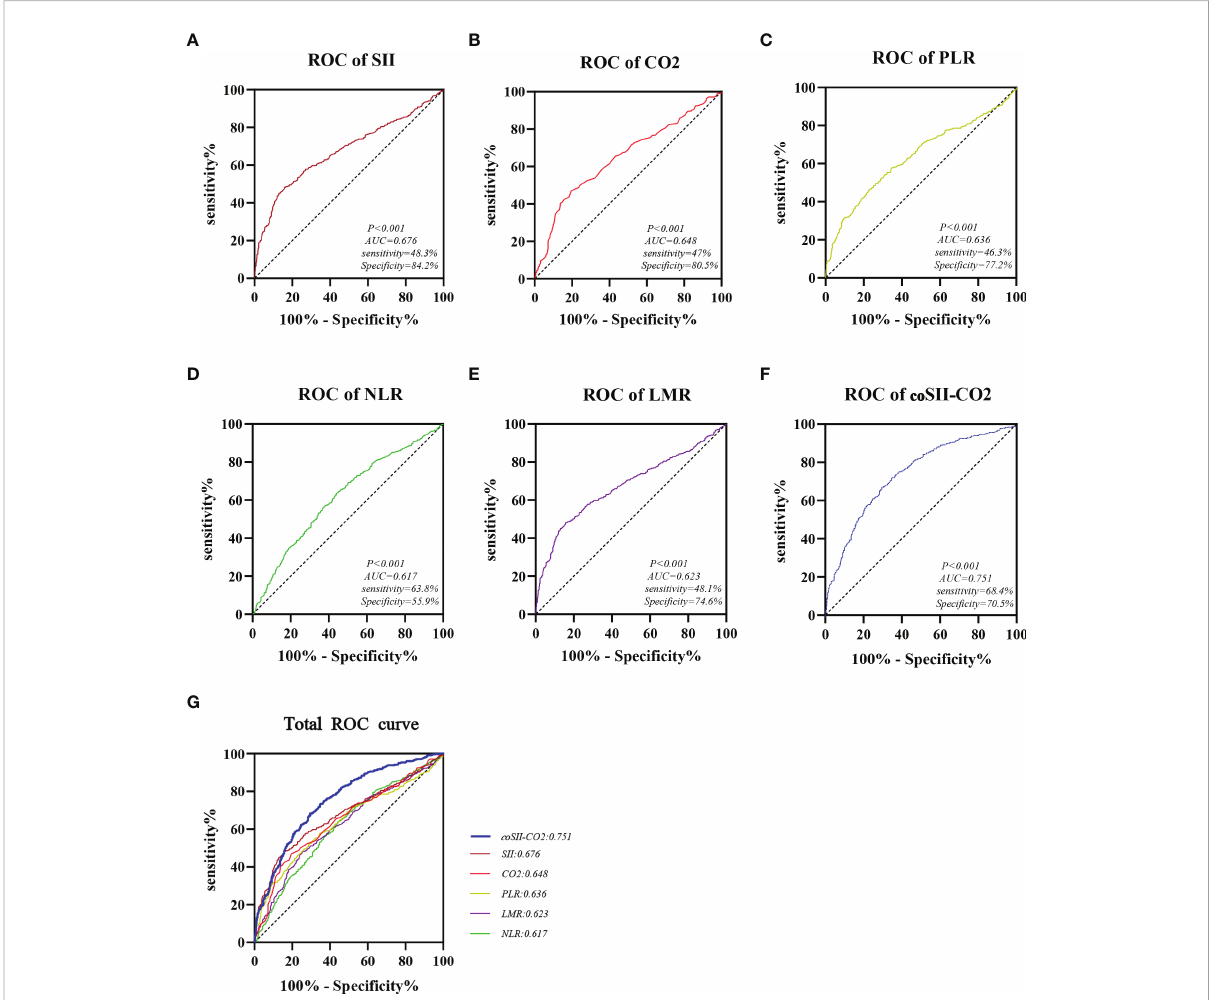
FIGURE 3 Areas under the curves of SII, CO 2 , PLR, NLR, LMR, and coSII-CO 2 . (A) The area under the curve of SII was 0.676. (B) The area under the curve of CO 2 was 0.648. (C) The area under the curve of PLR was 0.636. (D) The area under the curve of NLR was 0.617. (E) The area under the curve of LMR was 0.623. (F) The area under the curve of coSII-CO 2 was 0.751. (G) Compared with other independent predictive indicators, the area under the curve of coSII-CO 2 in the combined group was largest, thus indicating that coSII-CO 2 was the most accurate and reliable indicator for predicting the prognosis of patients with